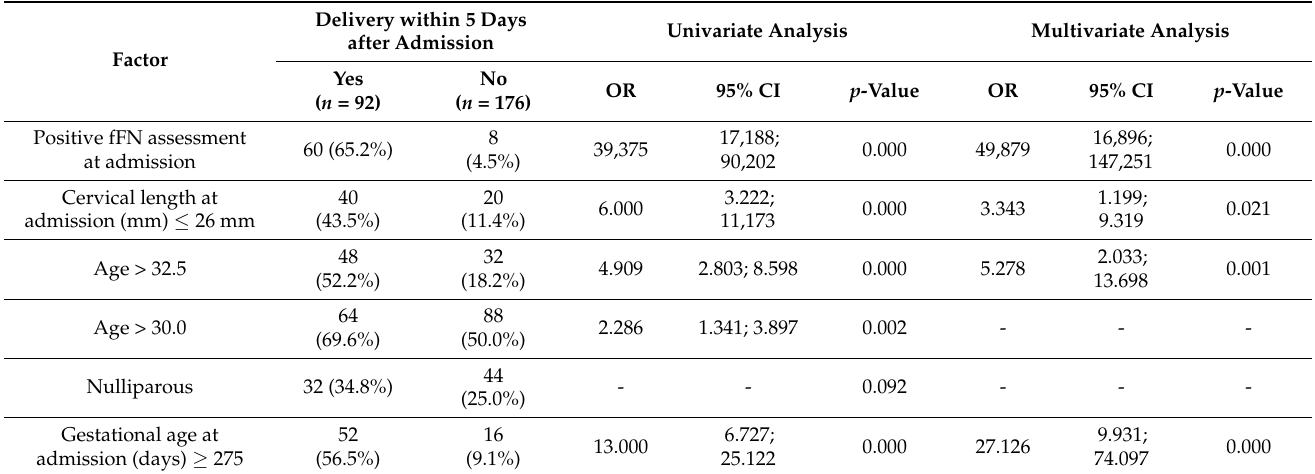
Table 2. Univariate and multivariate analysis of categorical prognostic